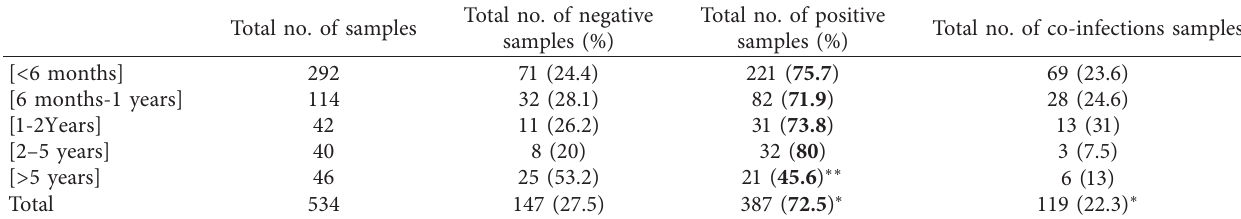
Table 2: Prevalence of respiratory pathogens in the five age groups ( n � 534). Total no. of samples